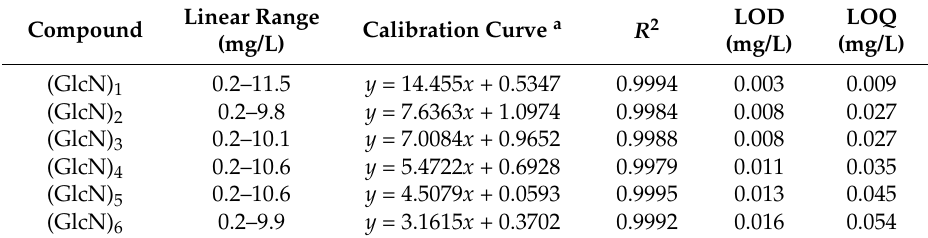
Table 1. Linearity of the calibration curve of (GlcN) 1–6